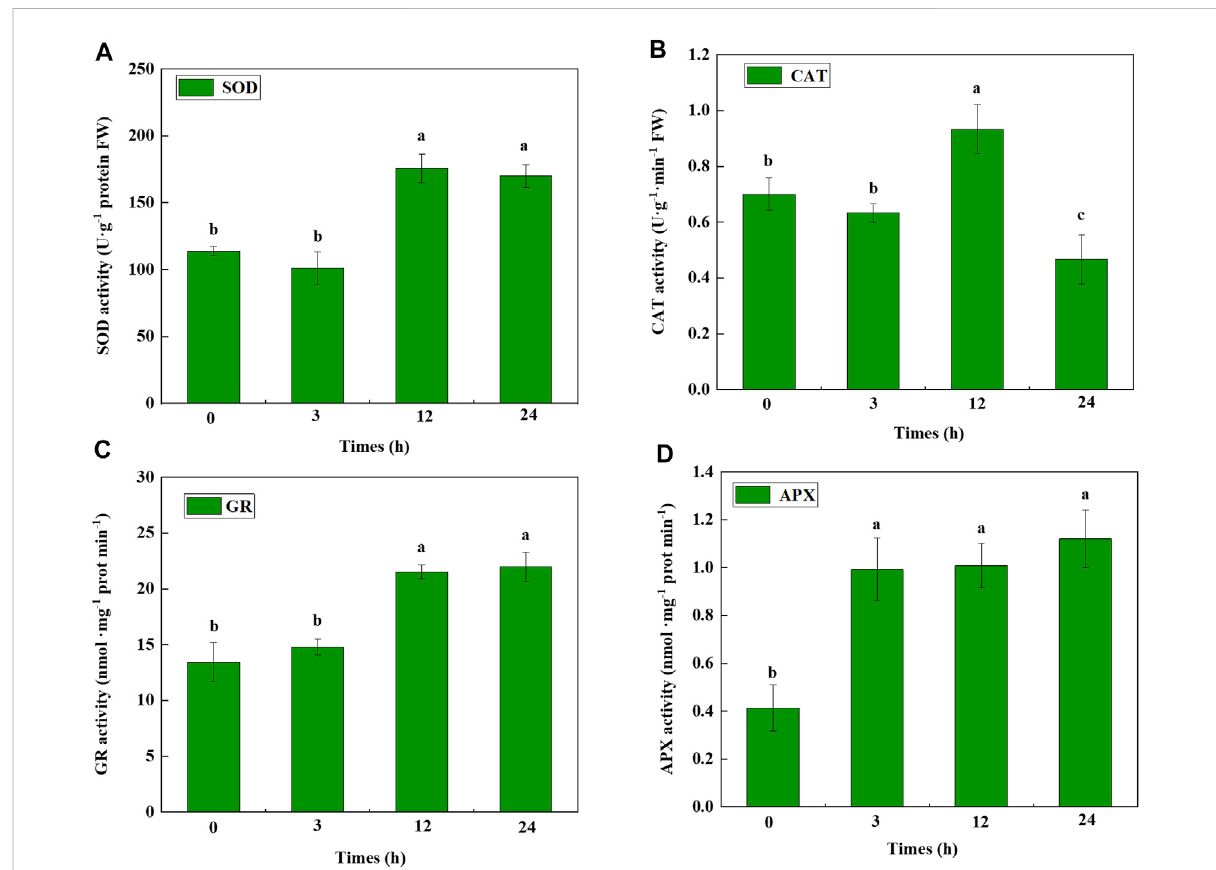
FIGURE 7 Antioxidant enzyme activity of cucumber seedlings under cold stress. (A) SOD, (B) CAT, (C) GR, and (D) APX activity determined at different hours after cold stress. Data were analyzed from three independent biological replicates and represent the mean ± SE. Different letters indicate signi fi cant differences at p < 0.05. SOD, superoxide dismutase; CAT, catalase; GR, glutathione reductase; APX, ascorbate